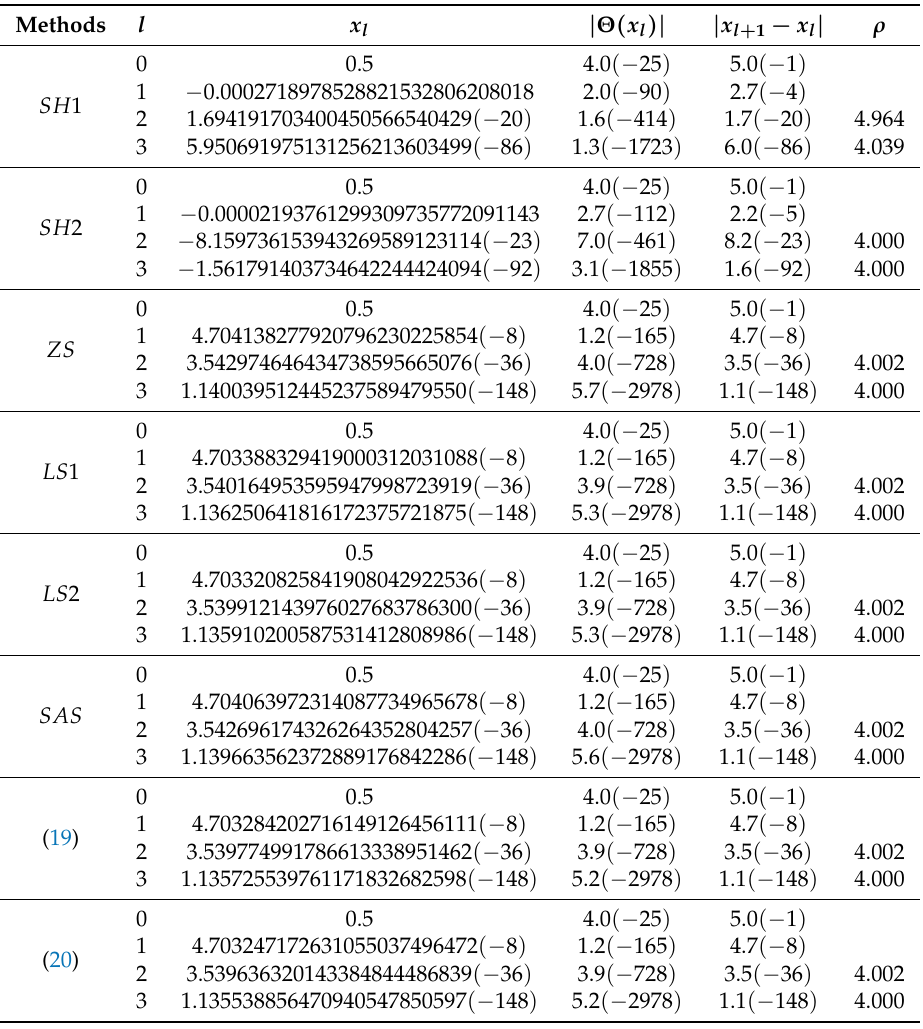
Table 5. Convergence study of distinct iterative functions on Θ 5 ( x )